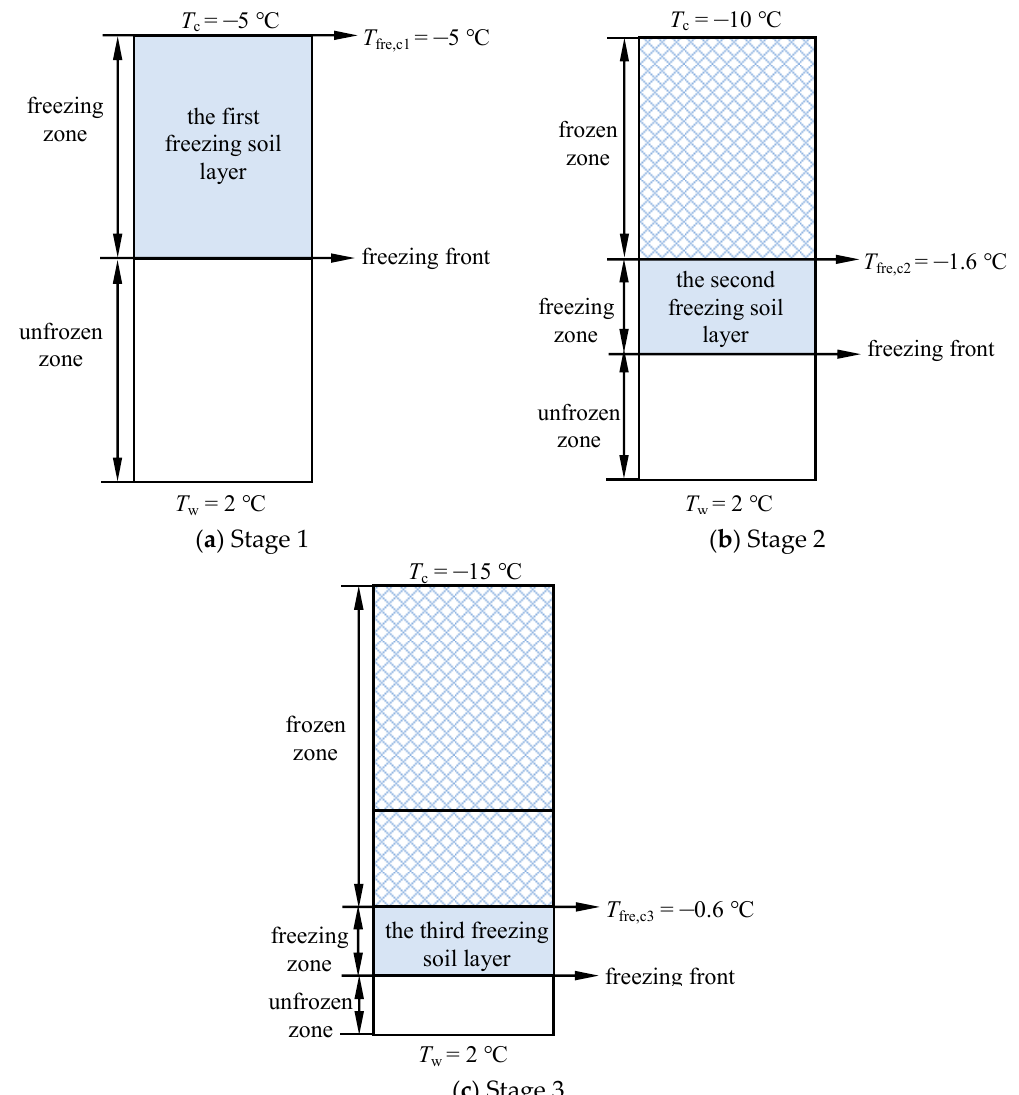
Figure 8. Fundamental principle of the generated frost heave during the multistage freezing during ( a ) stage 1, ( b ) stage 2, and ( c ) stage 3.